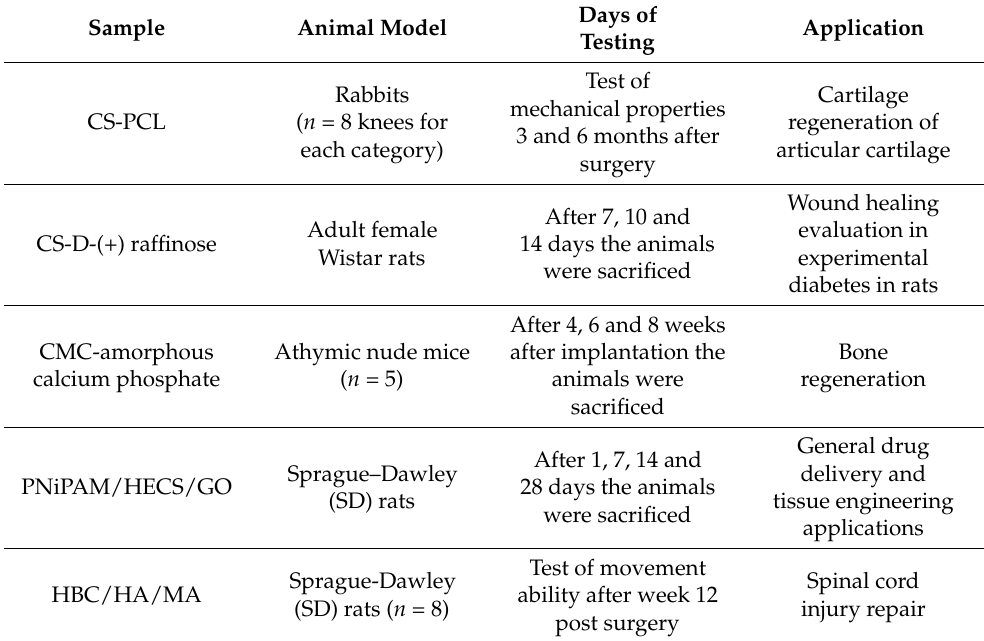
Table 1. Translations of 3D CS scaffold presented in this